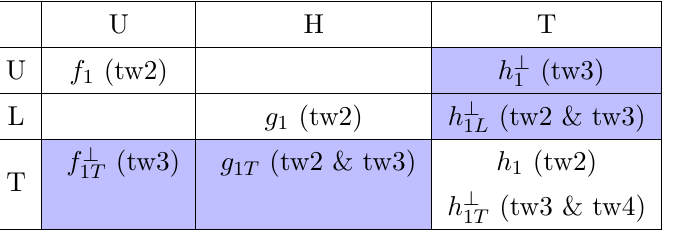
Table 1 . Quark TMDs sorted with respect to polarization properties of both the operator (columns) and the hadron (rows). The labels U, H, L, and T are for the unpolarized, helicity, longitudinal, and transverse polarizations. In brackets, we indicate the twist of collinear distributions to which TMDs match at small- b . The blue color highlights TMDs that are investigated in this